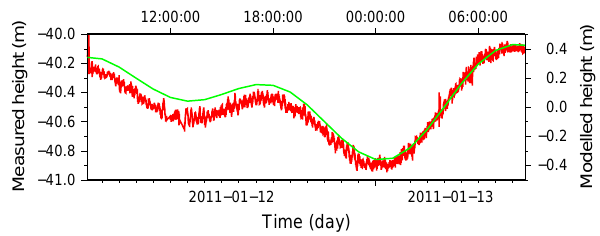
Figure 11. Modelled (green) and measured (red) tides between 12 and 13 January 2011. Surface displacements were measured on sea ice near the Astrolabe ice front by differential GPS with a baseline of less than 400m allowing for very accurate measurements and a noise level of less than